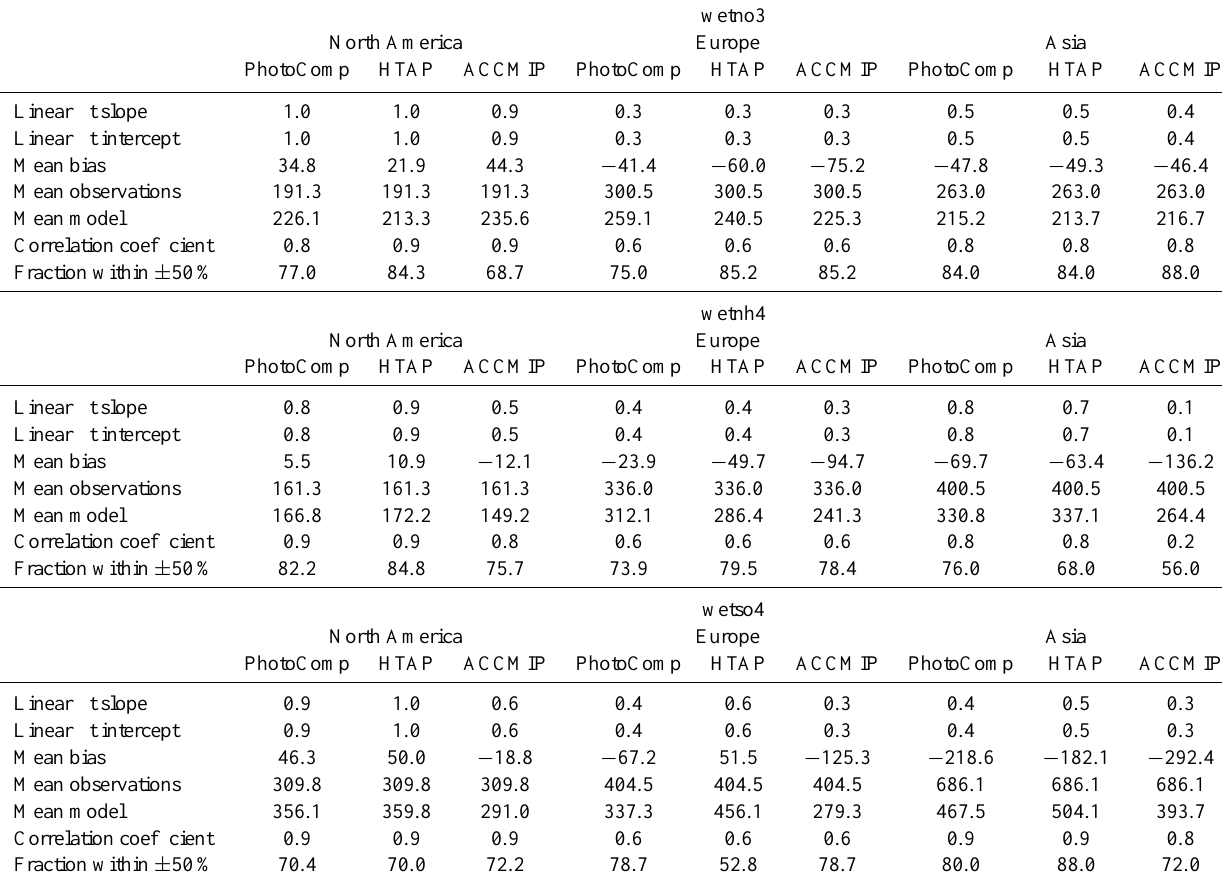
Table 5. Summary of statistical analysis of the evaluation of nitrate wet deposition (wetno3), ammonium wet deposition (wetnh4) and sulfate wet deposition (wetso4) for PhotoComp, HTAP and ACCMIP MMM over the 3 main analysis regions. Mean bias (model minus observations), observations and model are in mg(N or S)m − 2 yr − 1